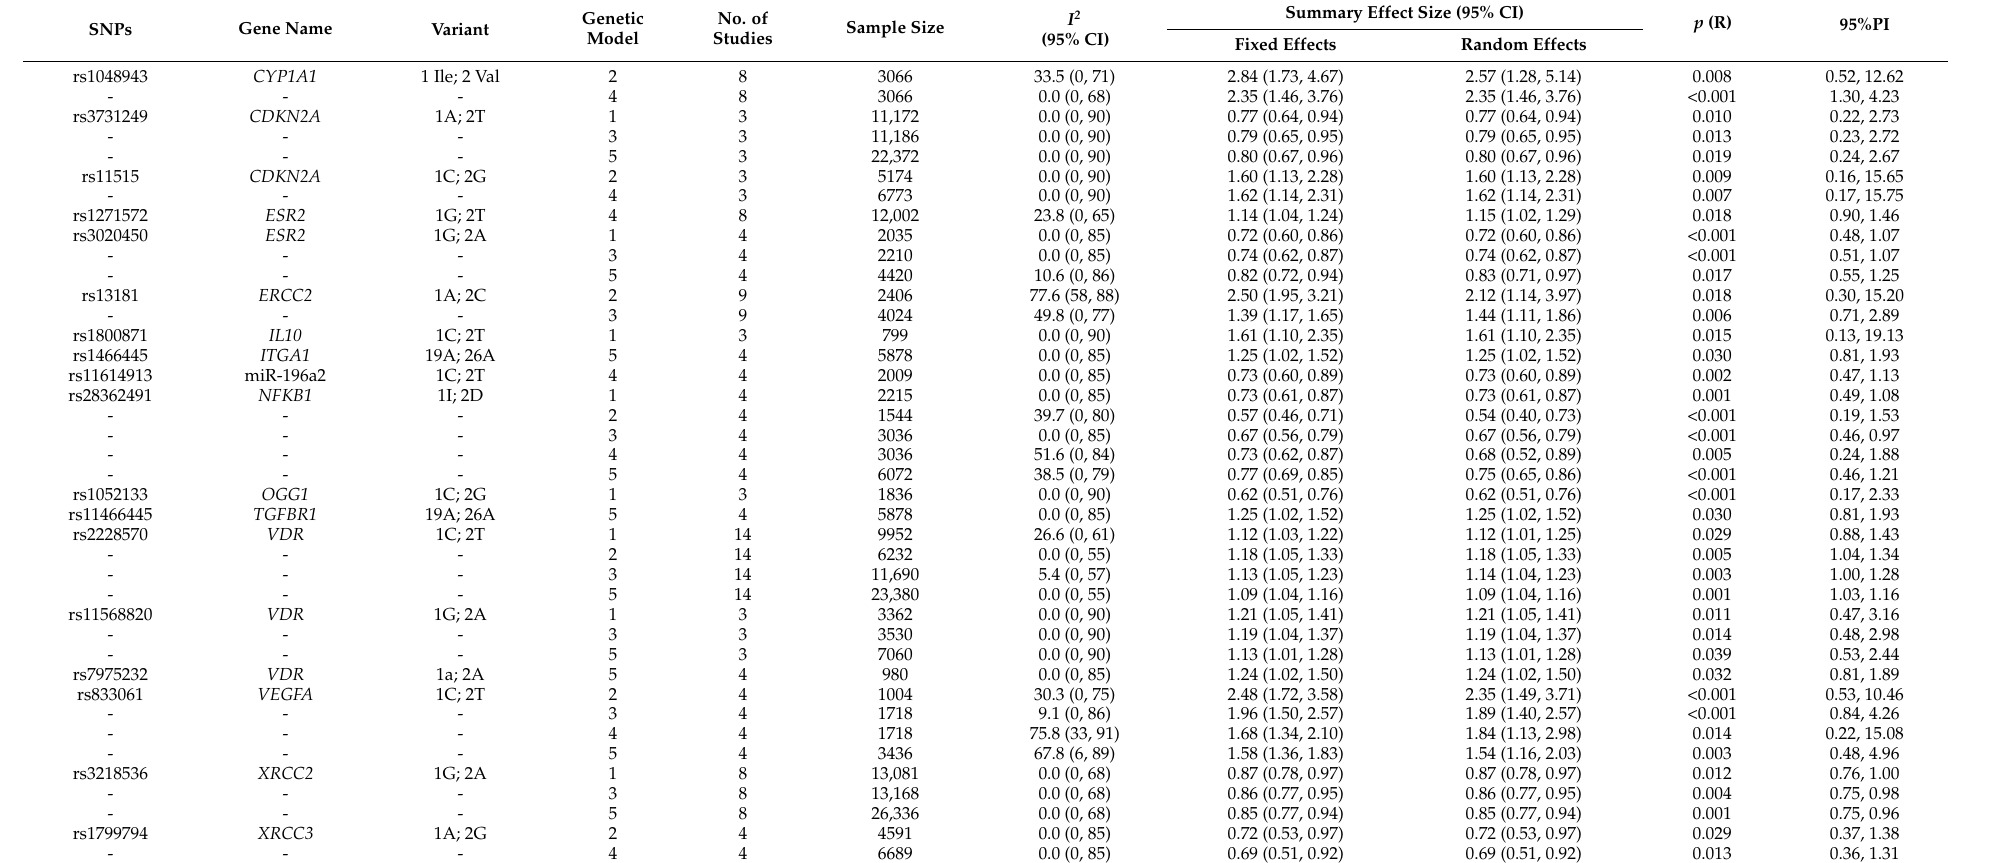
Table 1. Meta-analysis results of SNPs with nominal statistical